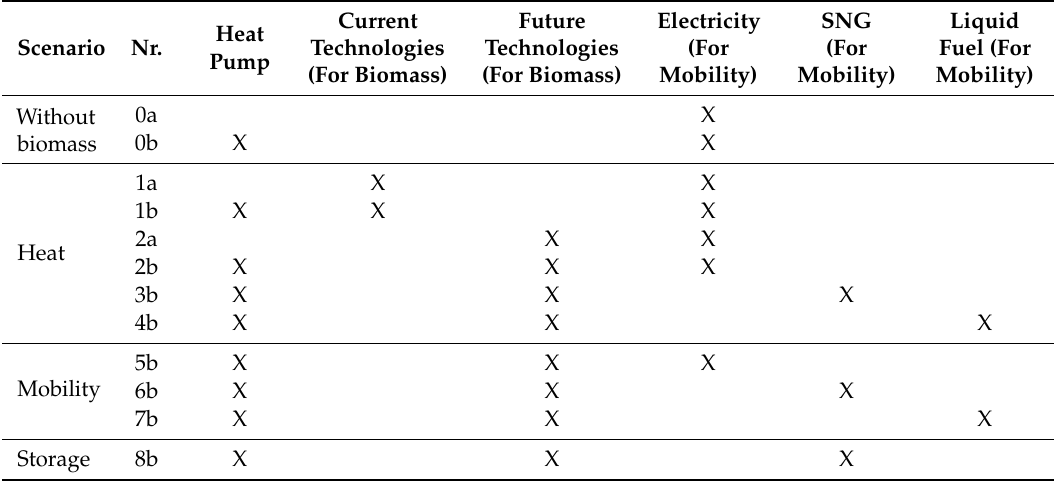
Table 4. Calculated variants (heat pump, current and future technologies, and biomass energy products for mobility) for the scenarios 0a until